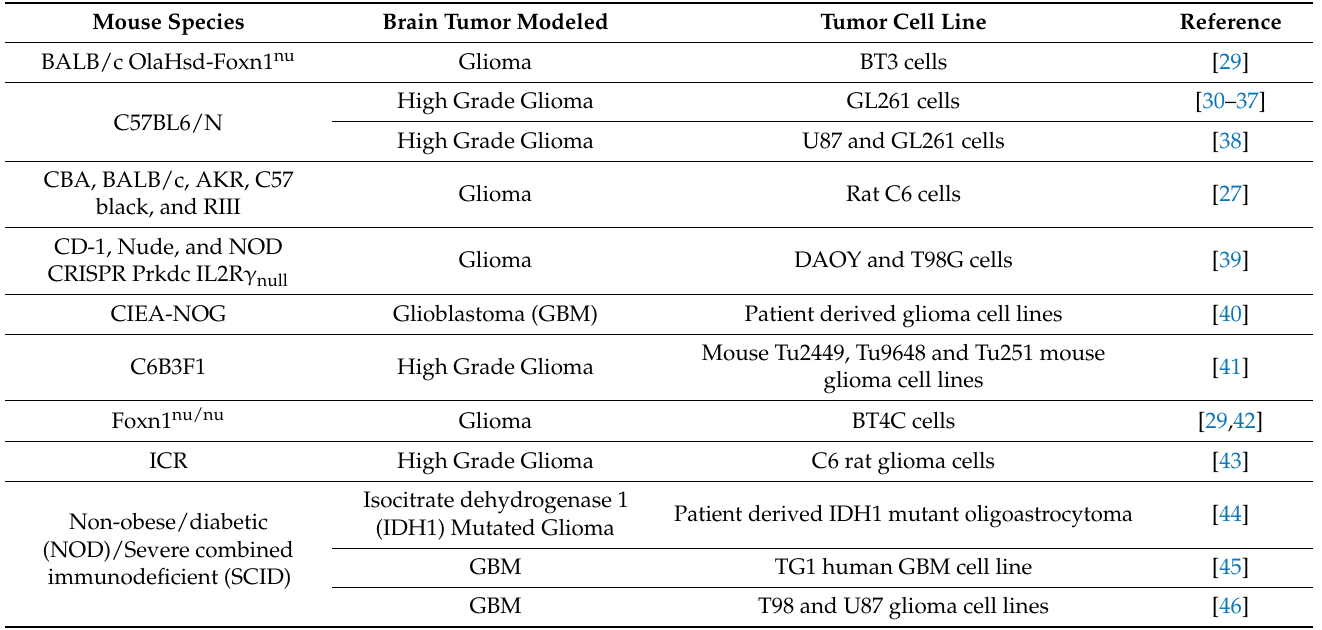
Table 2. Glioma cell-line xenograft (CLX) and syngeneic murine